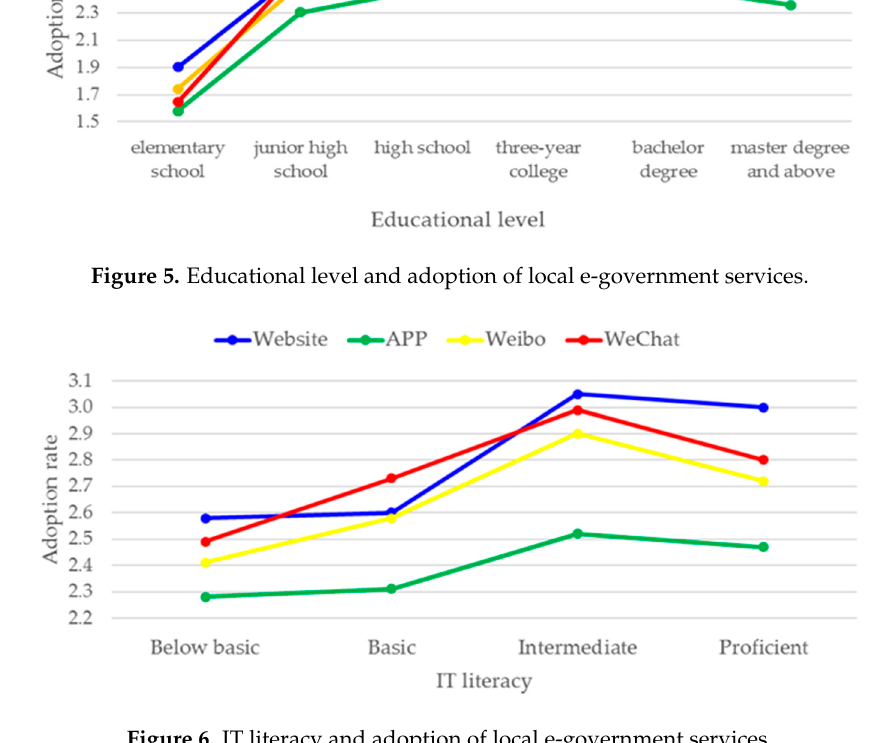
Figure 6. IT literacy and adoption of local e-government services.